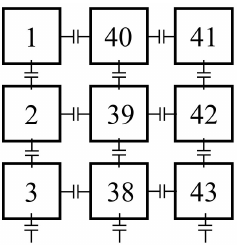
Figure 3. Stray capacitance taken into